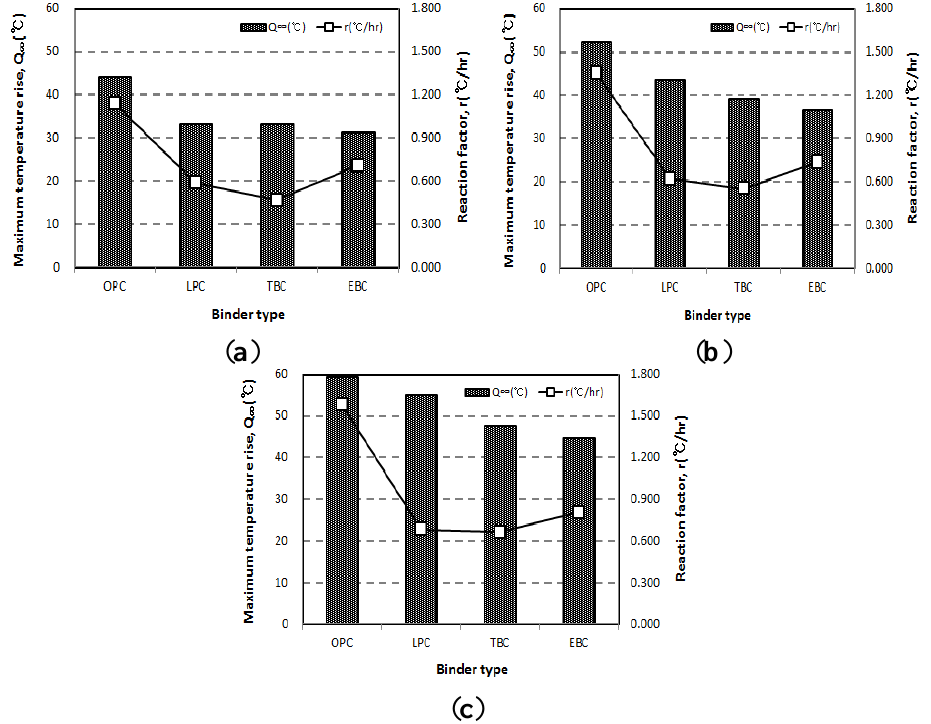
Figure 4. Results of the adiabatic temperature rise test for ( a ) unit weight of binder of 300 kg/m 3 ; ( b ) unit weight of binder of 400 kg/m 3 ; and ( c ) unit weight of binder of 500 kg/m 3